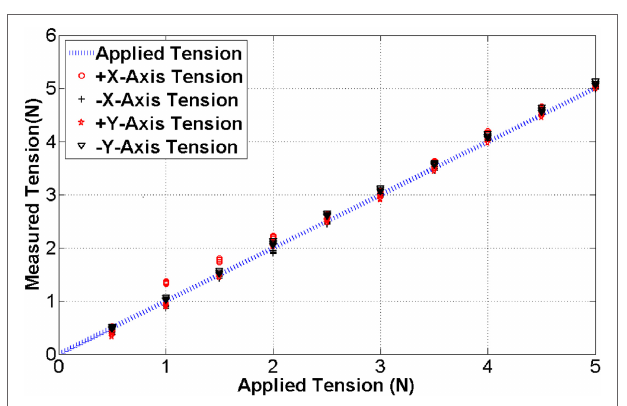
FigUre 4 | The blue line indicates the benchmark tension while the black and red dots are measured tension during the calibration .